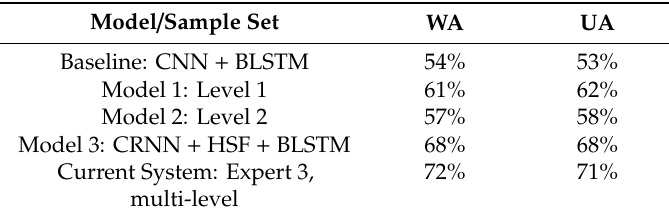
Table 5. Test result of expert 3.